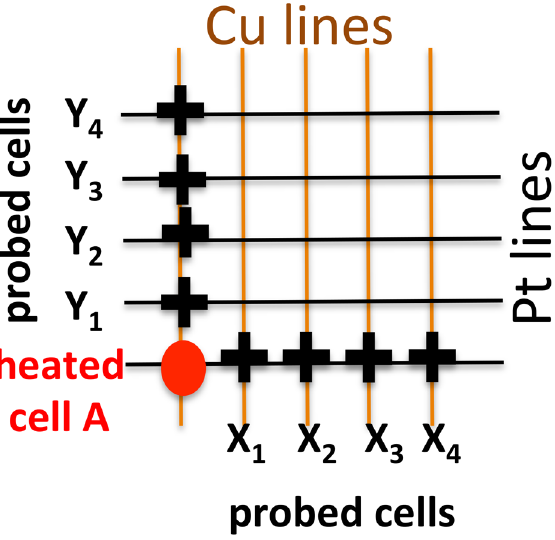
Figure 2. A crossbar array of Cu/TaO x /Pt cells. The cell A marked by the red dot represents the heat source cell. The cells affected by the heat source are disposed along the Cu and Pt line and marked by black crosses and X i and Y j . All these probed cells are set prior to heating by cell A to an ON-state under various I cc constraints. Immediately after the heating of cell A has ended, the conductivity of the cells X i and Y j is probed at small voltage bias ≤ 0.1